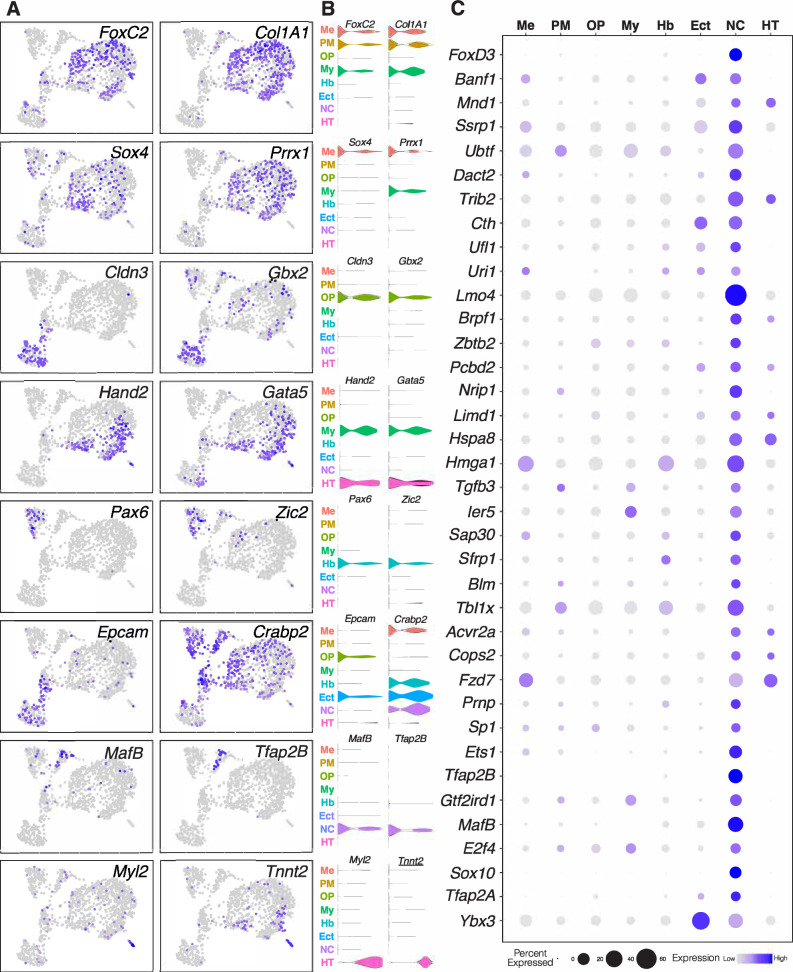
Identification of novel genes expressed in the neural crest.(A) Feature plots showing expression of marker genes in low-dimensional space used to identify all eight sub-clusters within the chick hindbrain. (B) Violin plots showing the distribution of expression of these marker genes (A) in surrounding cell types. (C) Relative expression of all genes expressed in the neural crest cluster that share the GO terms ‘DNA binding’, ‘transcription factor’, and ‘regulation of transcription’. Several of these genes are transcriptional regulators and/or chromatin remodelers that are ubiquitously expressed in surrounding tissues. The radius of each point reflects the proportion of cells within individual clusters that express a specific gene, whereas the relative expression is reflected by the color of the point (grey – low/negative expression, blue – high expression). A subset of these genes are highlighted in Figure 1E.